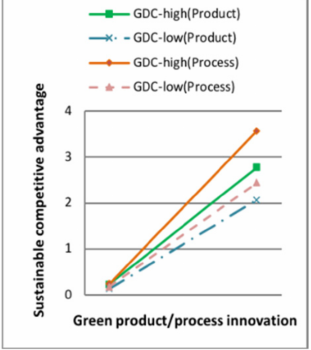
Figure 7. The moderating effect between GI and